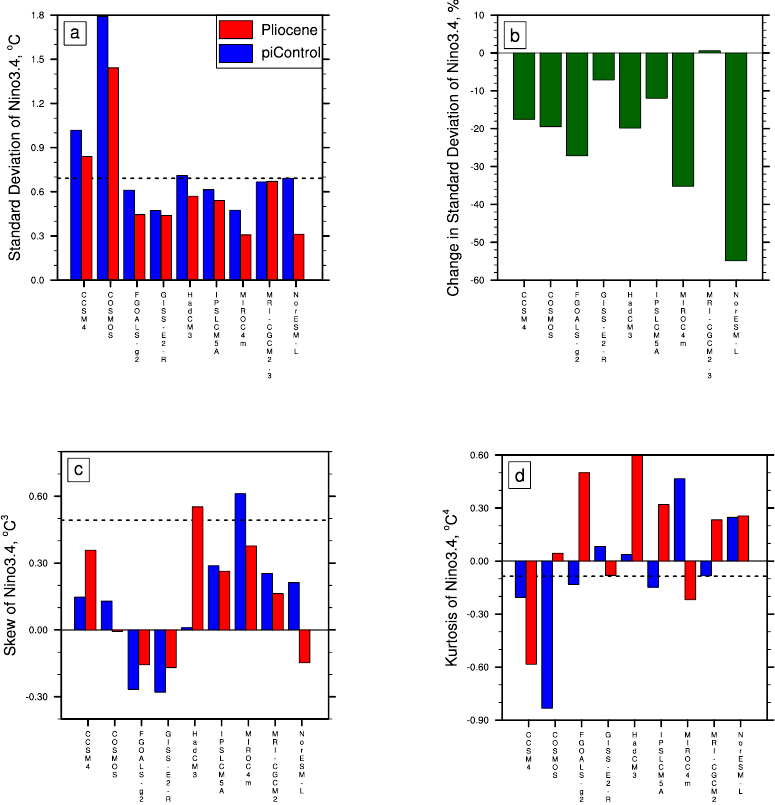
Figure 1. The moments of the distributions of the Niño 3.4 sea surface temperature anomalies in the ensemble members. The first moment (i.e. the mean) is 0 by definition. The standard deviation shows the amplitude of the SST variations. If the skew is positive, then the El Niño tail is stronger than the corresponding La Niña state. If the kurtosis is greater than 0, then the distribution is more peaked than a Gaussian. The dashed line shows the moment of the ERSST